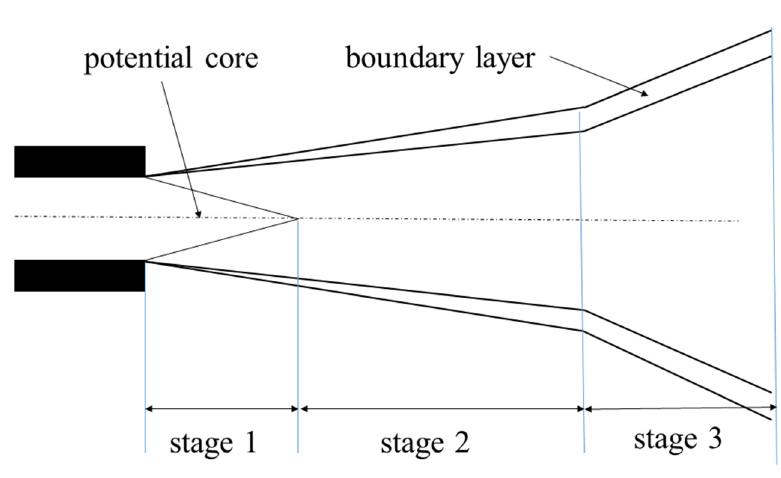
Figure 4. Schematic diagram of high pressure water jet diffusion.